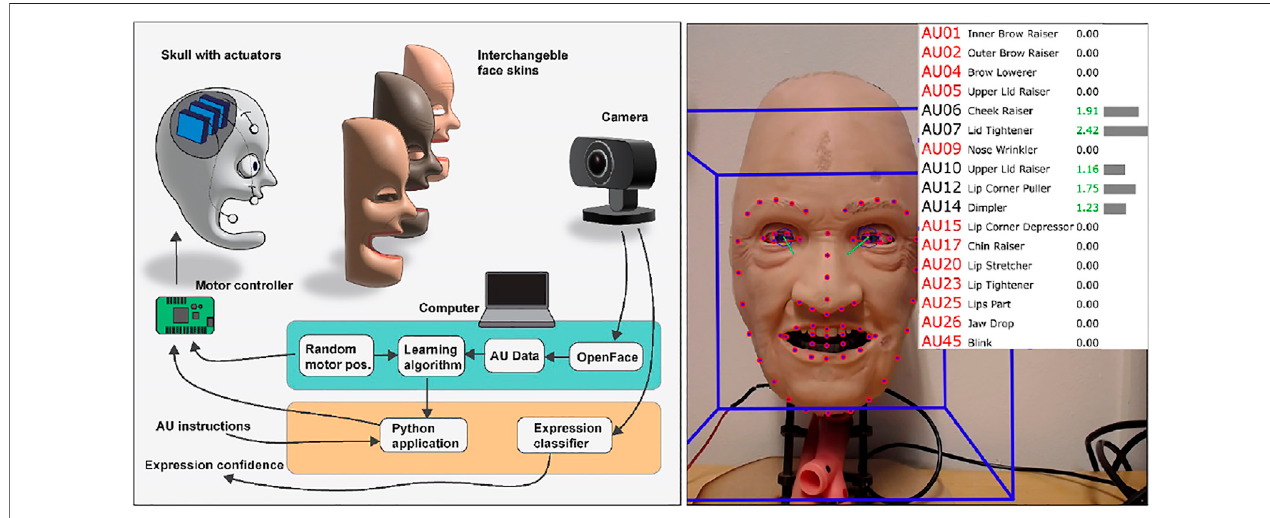
FIGURE 3 | Pipeline for controlling and analyzing the robotic face, with an example frame captured and analyzed with OpenFace 2.0.